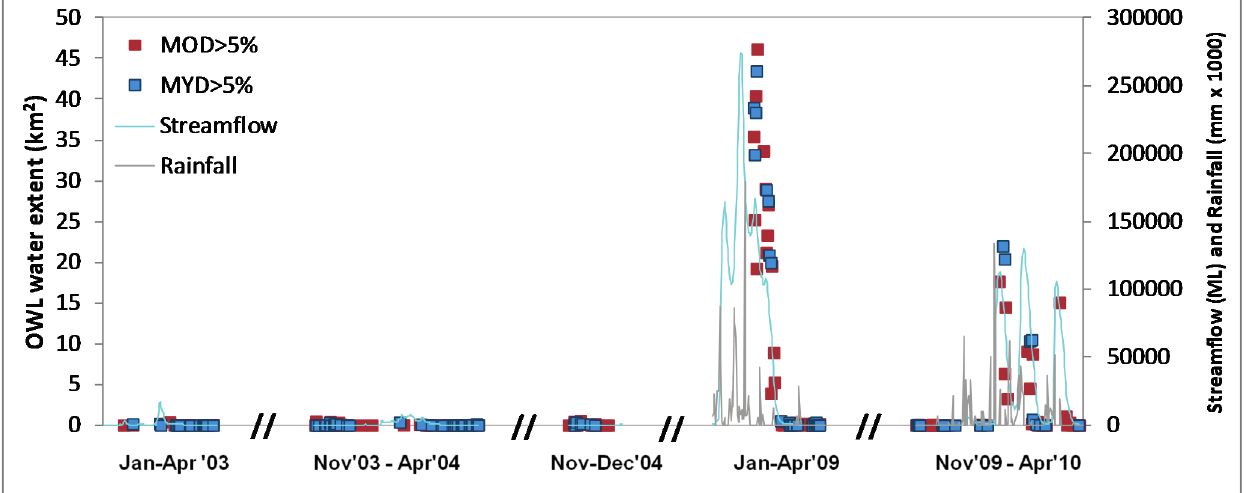
Figure 7. MODIS OWL flood extent (using only those pixels mapping greater than 5% inundation) for the MOD and MYD data for Site W2, for the 2003, 2004, 2009 and 2010 wet seasons. Rainfall and streamflow are also